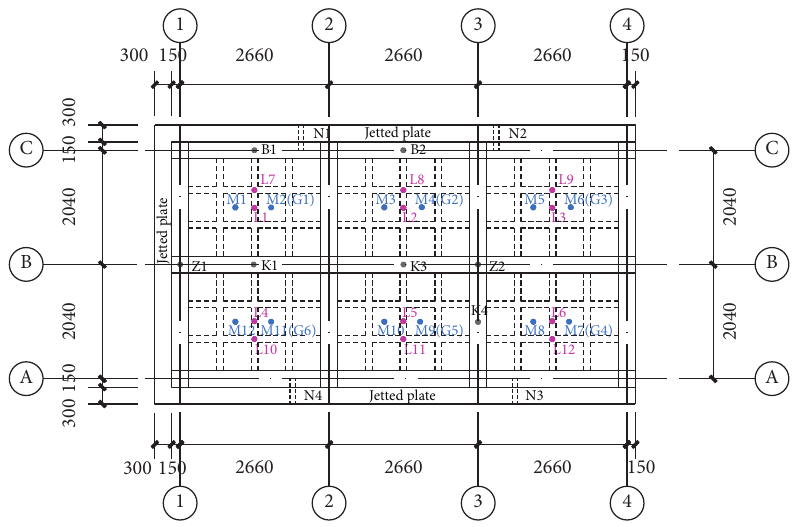
Figure 7: Furnace thermocouples and thermocouple trees in the AMH slabs.